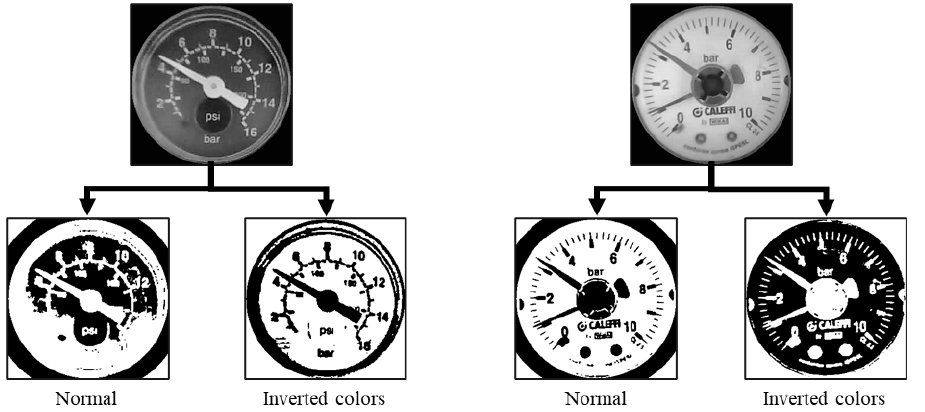
Figure 8. Binarization of the RoI and the inverted colors